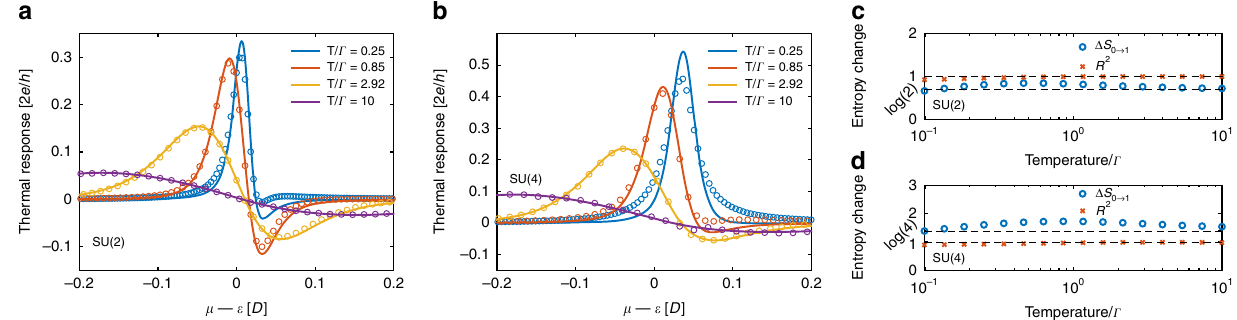
Fig. 2 Extension of the procedure to low temperatures. Fitting of the TR obtained directly from NRG (solid line) with TR obtained from Eq. (4) (circles), for the a two-fold, and b four-fold degenerate quantum dot, in the vicinity of the fi rst CB peak, for various temperatures. c , d Calculation of the entropy change across the fi rst CB peak for a wide range of temperatures for a c two-fold, and d four-fold degenerate quantum dot, where the expected entropy changes are log2 and log4 , respectively. The closeness of the R 2 estimate of the fi tting procedure (crosses) to unity indicates the excellent agreement between the two curves of TR, as shown in a , b . The x -axis in a , b is in units of D , half the bandwidth in the leads, and Γ ¼ 0 : 01 D and U ¼ D in all three